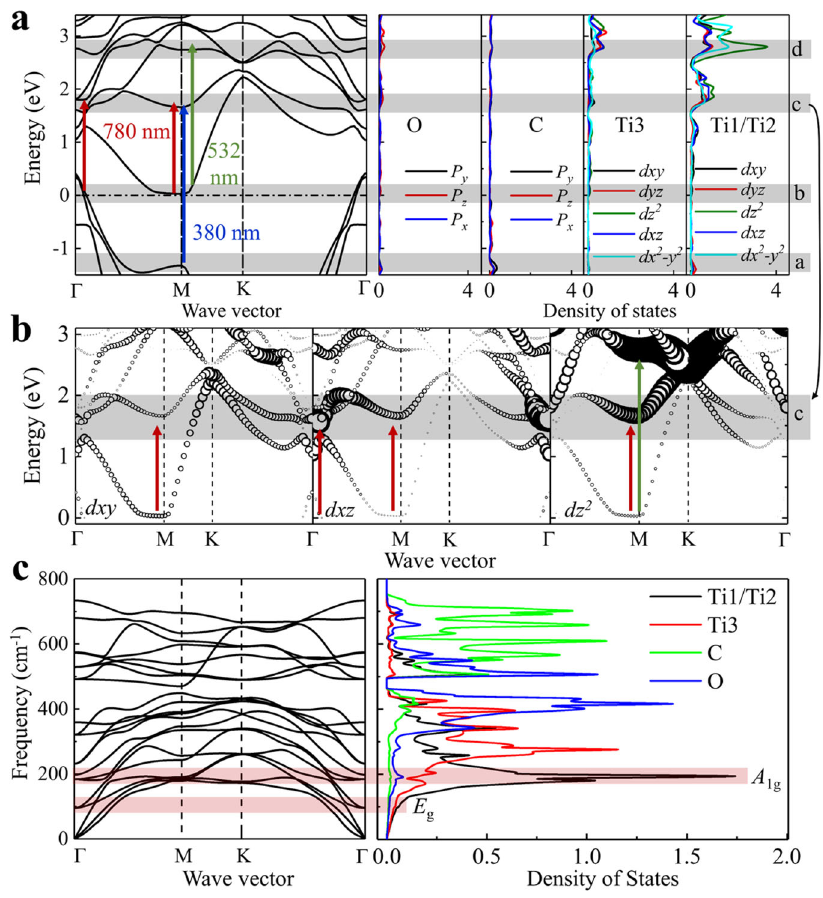
Fig. 4 | The calculated band structures and density of states (DOS) of Ti 3 C 2 T x (Ti 3 C 2 O 2 ).a HybridfunctionalelectronstructuresandDOS.Markedaround − 1.3eV as the a band, around − 0.3eV as the b band, and about 1.6eV as the c band (main